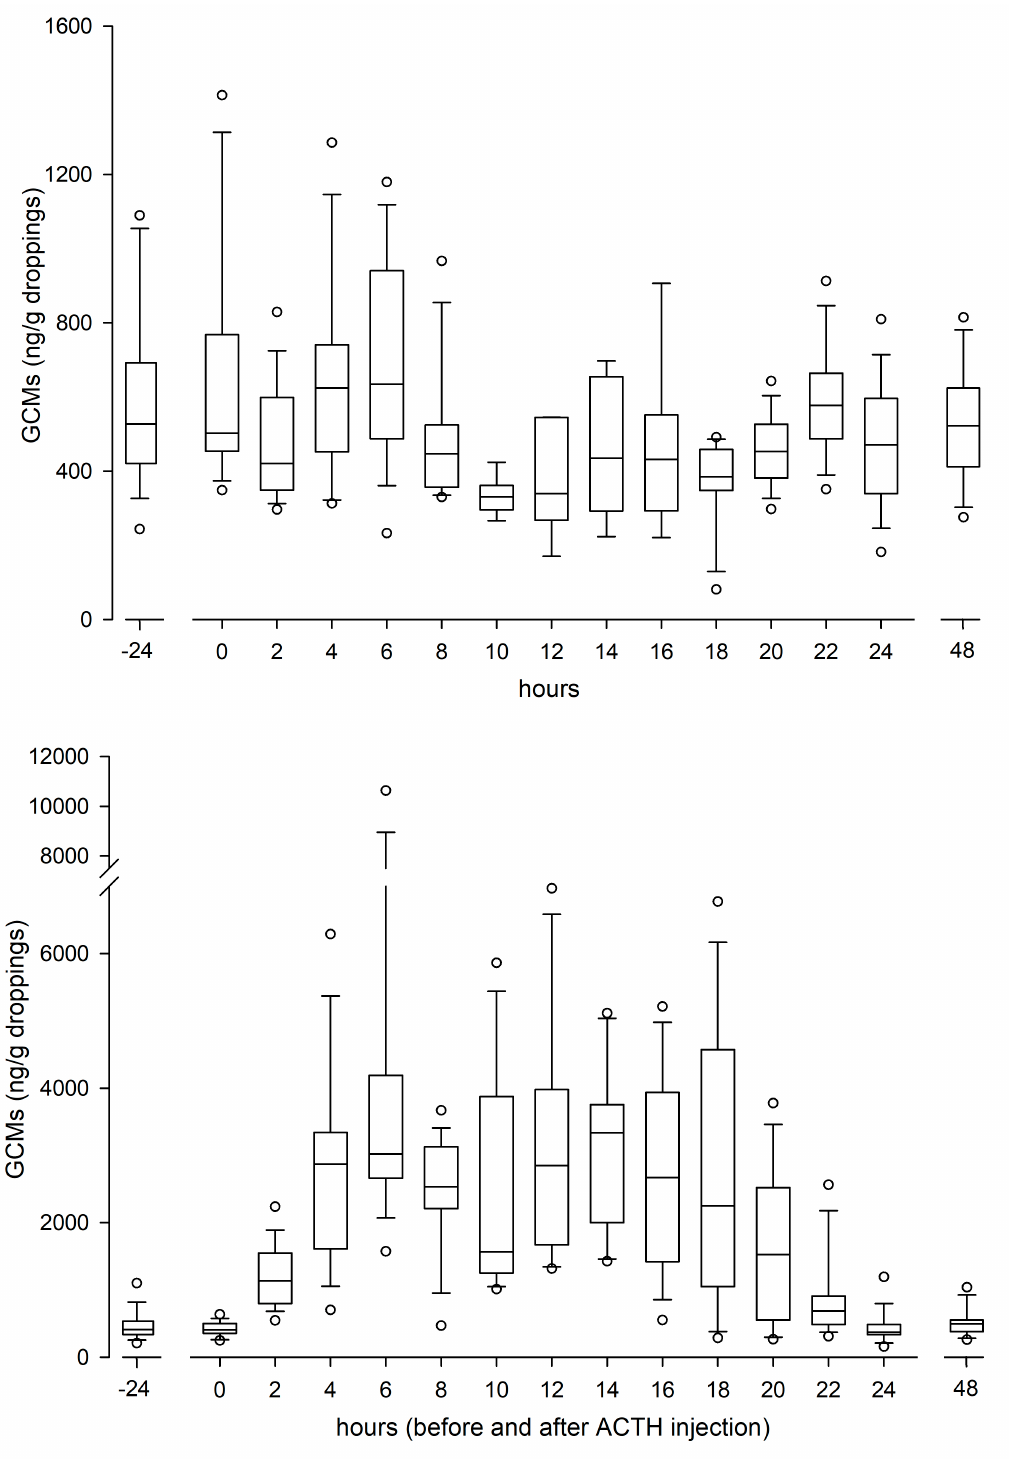
Figure 1. Box-plot graphs of concentrations of glucocorticoid metabolites (GCMs) in golden conure ( Guaruba guarouba ) excrements, in undisturbed control (upper panel) and ACTH injected (lower panel; n = 16 each) birds. Note the different y-axes scales.